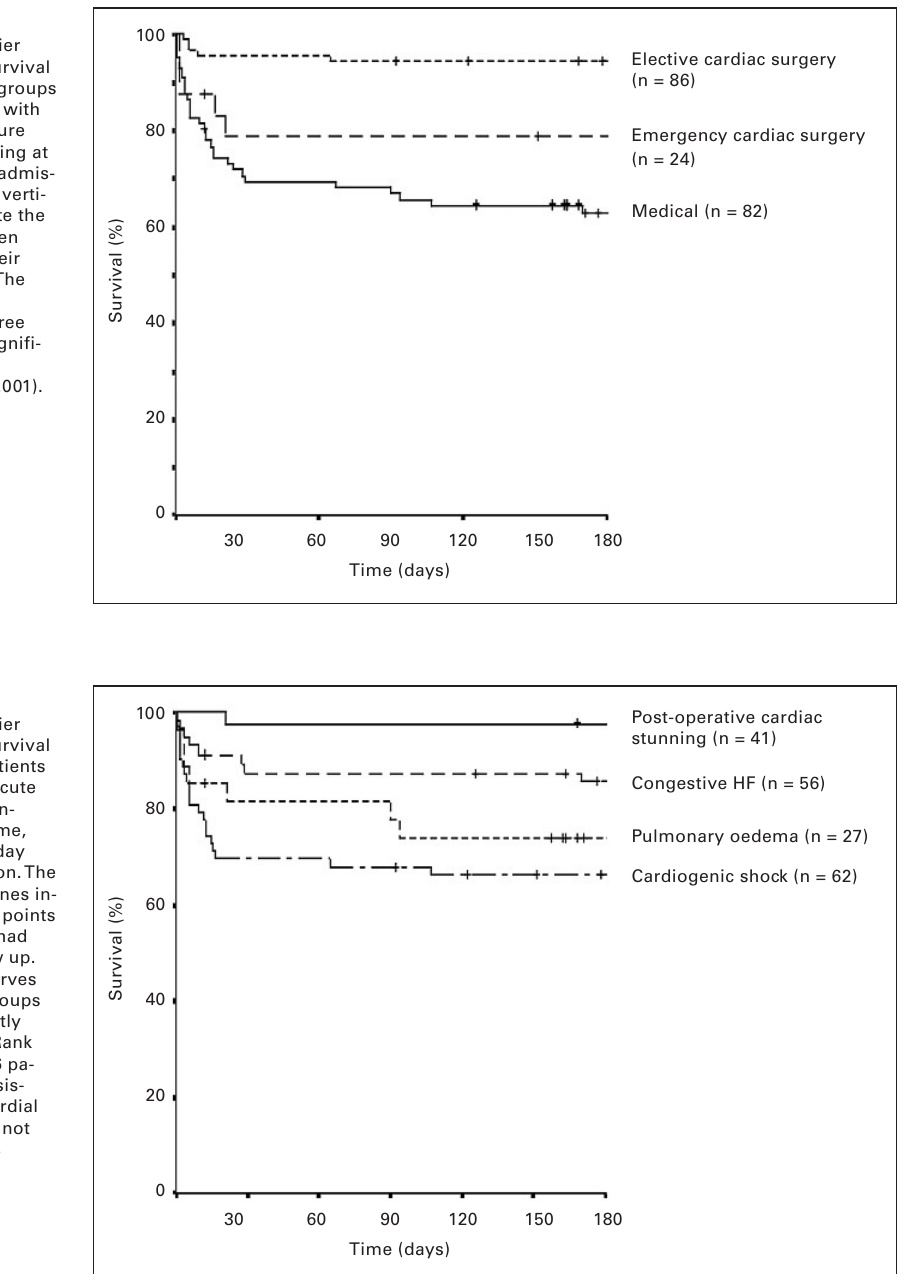
Figure 3 Univariate risk fac- tors for mortality. Bars represent haz- ard ratios with 95% confidence intervals. A value >1.0 indicates an increased risk of mortality, a value <1.0 denotes a risk reduction. Bars cross- ing 1.0 do not reach statistical signifi- cance. LV denotes left ventricular, CVP cen- tral venous pressure, BP blood pressure, p a O 2 /F i O 2 arterial par- tial pressure of oxy- gen per fraction of inspired oxygen, and NT-proBNP N-termi- nal pro B-type natriuretic